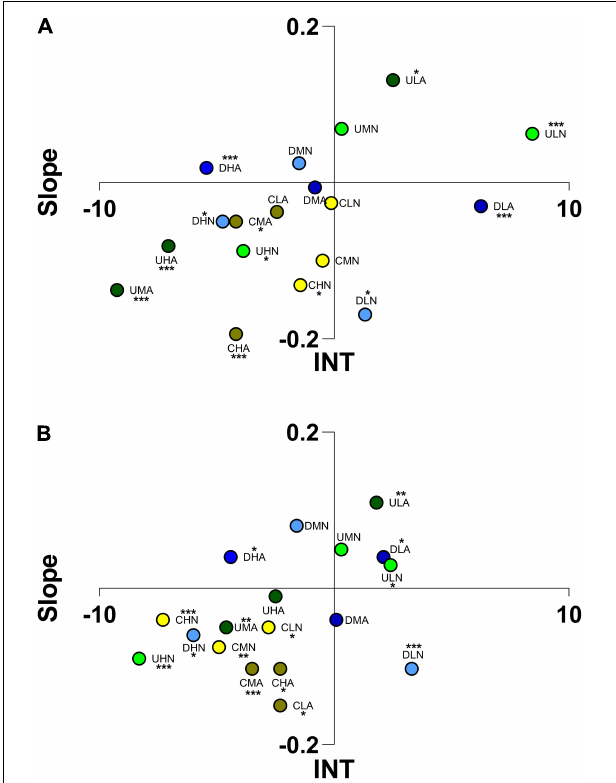
FIGURE 7 | Ordination into 1 of 4 sectors of Hippolyte inermis adults according to the scores reached for “Slope” and “INT” (integral time) in static arenas (A) and flow-through flumes (B) . The letters indicate the algae considered (C, Cocconeis scutellum var. parva ; D, Diploneis sp.; U, Ulva prolifera ), the concentration of VOCs (L, low; M, medium; H, high), and the culture and test conditions (N, normal conditions; A, acidified conditions). Asterisks indicate the significance of individuals’ position in the space.